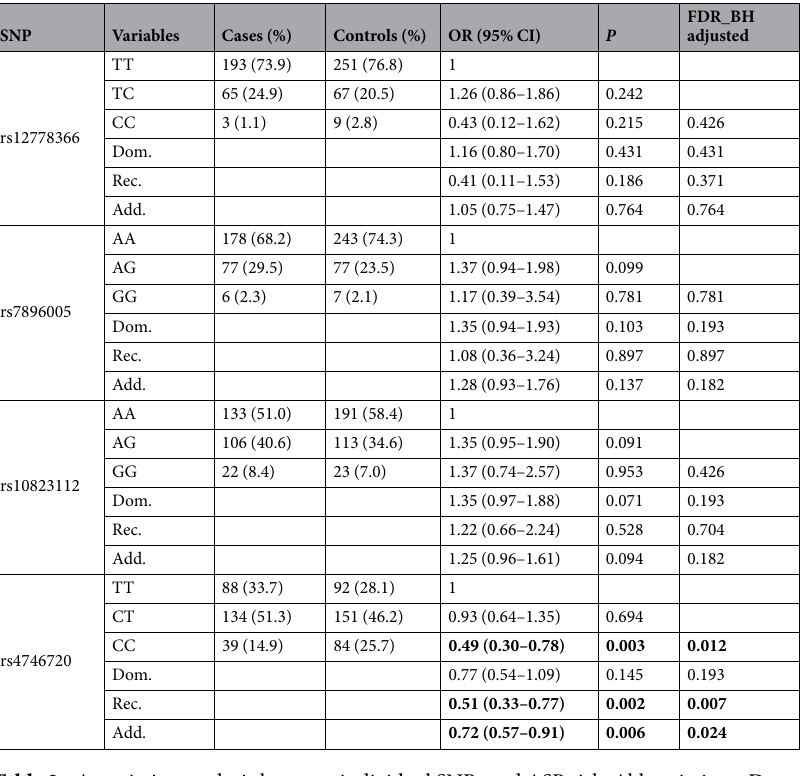
Table 3. Association analysis between individual SNPs and ASP risk. Abbreviations: Dom, dominant model; Rec, recessive model; Add, additive model; OR, odds ratio; 95% CI, 95% confidence interval; FDR_BH, false discovery rate-Benjamini and Hochberg. Positive results are in